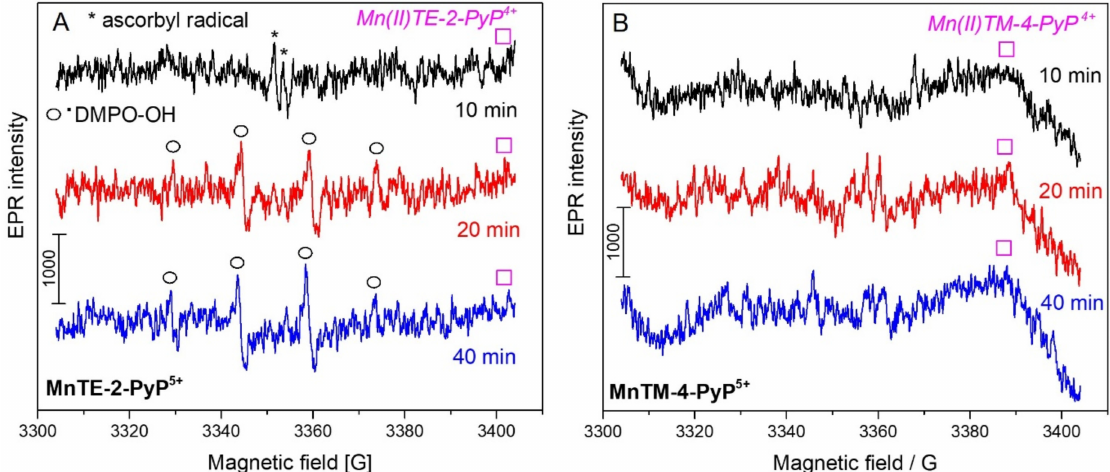
Figure 7. Time evolution of EPR spectra of DMPO spin adducts and of ortho Mn(II)TE-2-PyP 4+ ( A ) and para Mn(II)TM- 4-PyP 4+ ( B ) state in the aqueous solutions saturated with air at room temperature for the system: 250 µ L water solution containing 1 µ M Cu(II), 100 µ M Mn(III)P, 1.75 mg/mL HA and 100 µ M AscH − + 50 µ L DMPO (25 µ L DMPO/1 mL H 2 O) for MnTE-2-PyP 5+ ( A ) and for MnTM-4-PyP 5+ ( B ) (*—ascorbyl radical; — • DMPO-OH adduct; χ —signal from Mn(II) (cid:35)